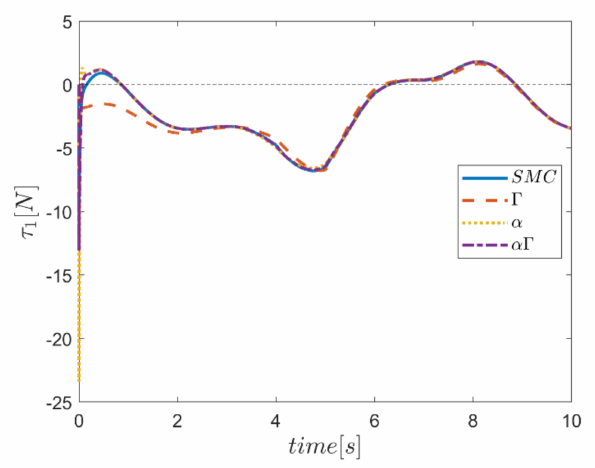
Figure 28. Comparison of the input force in the first actuator.